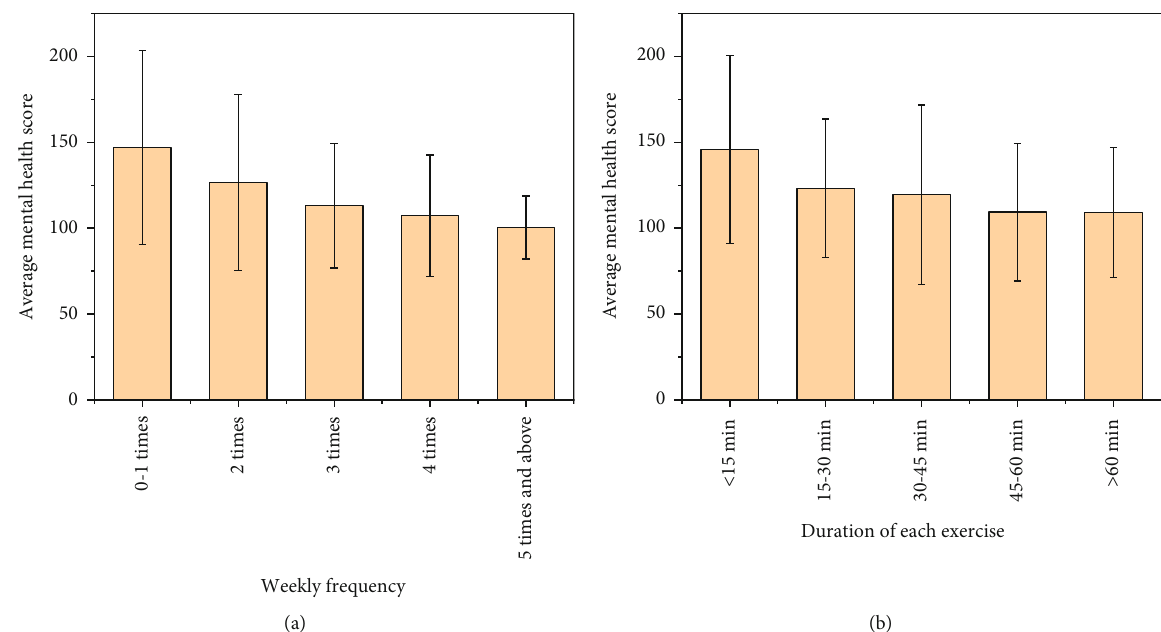
Figure 9: Results of investigation on the relevance of exercise frequency and duration to disease belief ((a) exercise frequency; (b) exercise duration).